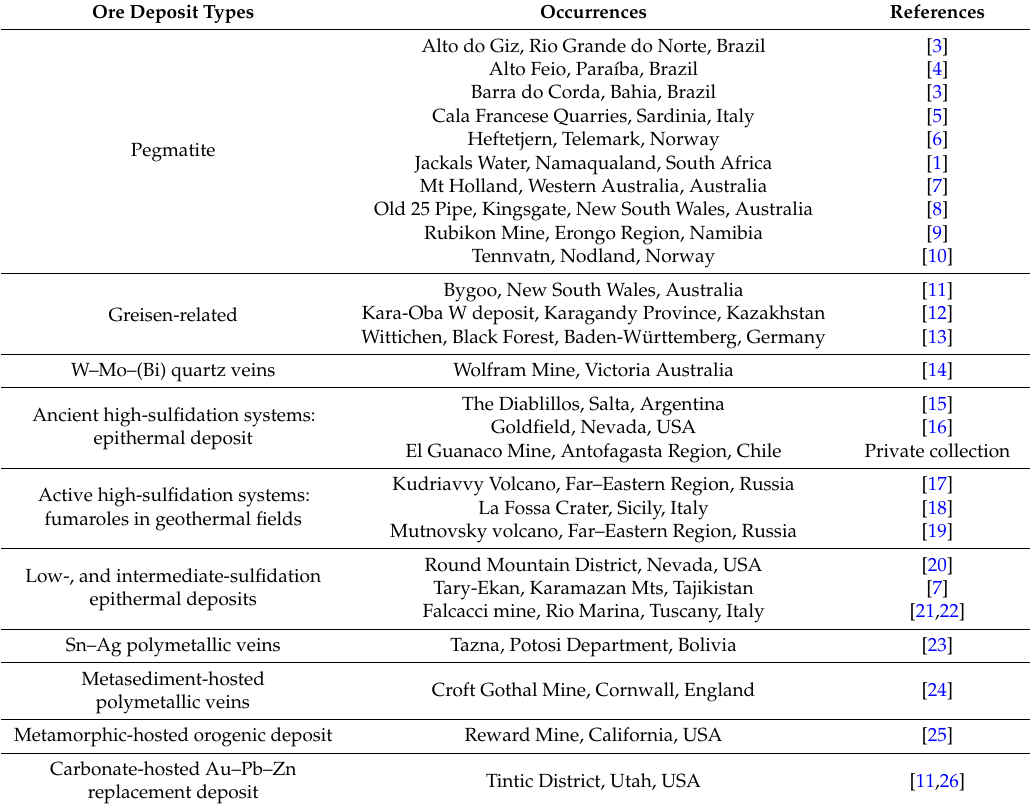
Table 1. Global occurrences of bismoclite, subdivided by deposit